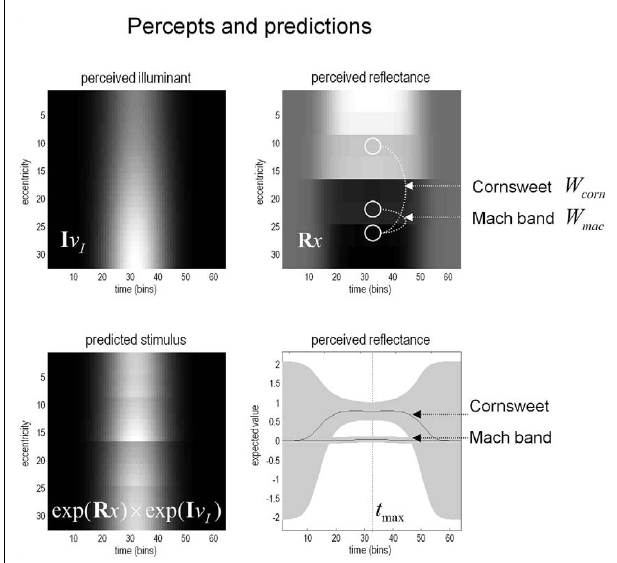
FIGURE 7 |The model’s “perceptions.” The upper panels show the predicted illuminance (left) and reflectance profiles (right), reconstructed from the coefficients of the basis functions estimated from the model inversion shown in the previous figure. An inferred reflectance profile demonstrating the Cornsweet illusion is apparent, but at this level of contrast, Mach bands have not yet appeared. Please see main text further